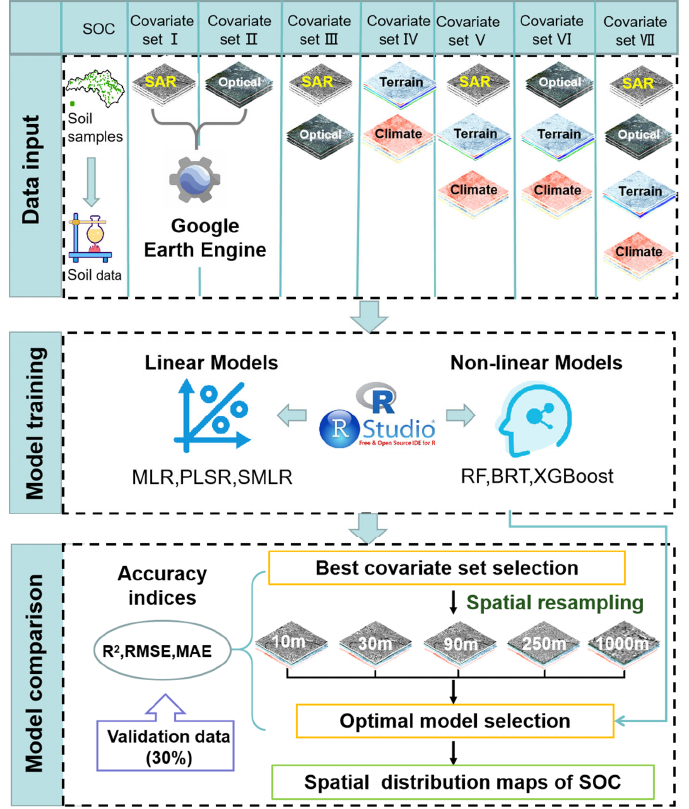
Figure 2. Workflow diagram for predicting SOC in this study.